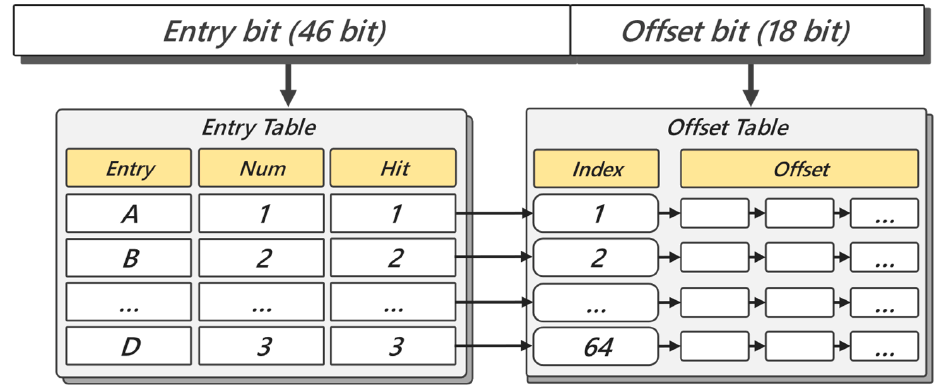
Figure 4. Prefetch table schematic diagram.